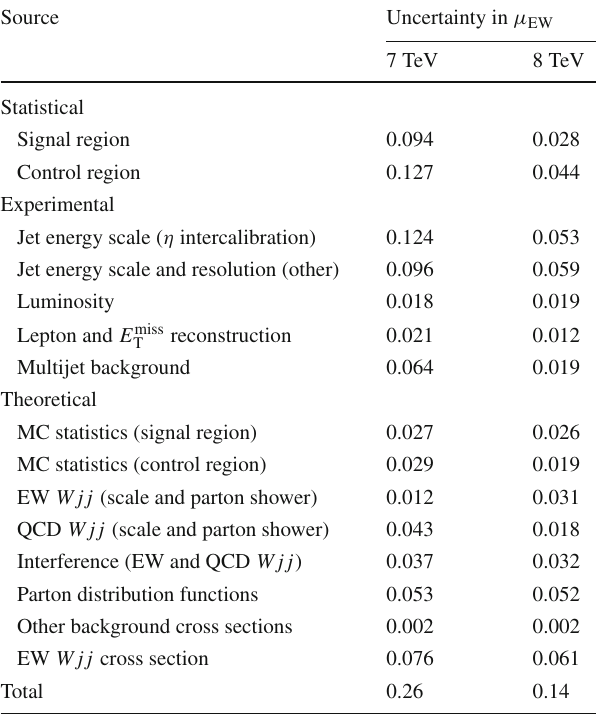
Table 5 The statistical and systematic uncertainty contributions to the measurements of μ EW in 7 and 8TeV data